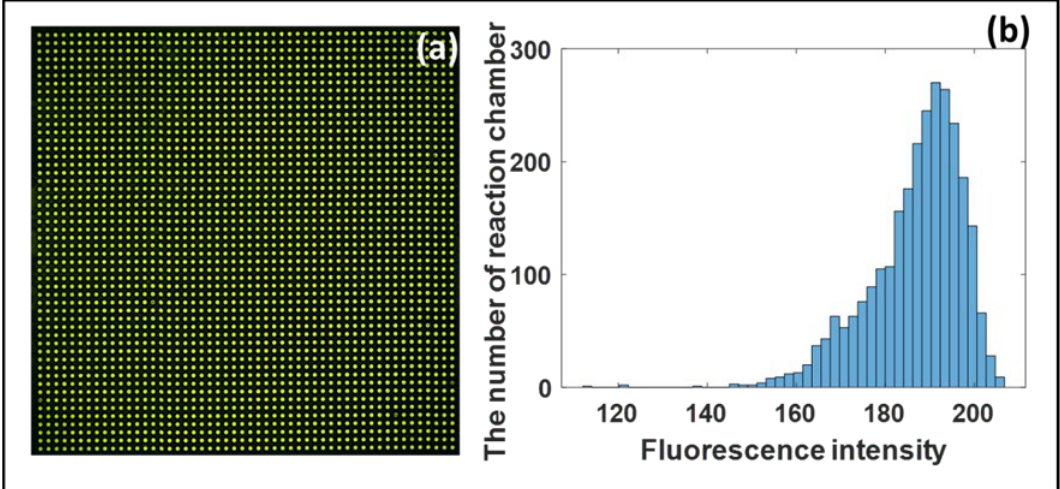
Figure 5. ( a ) Fluorescent images of the solution distribution in the microfluidic chip. ( b ) Histograms of the fluorescence intensity of every reaction chamber.